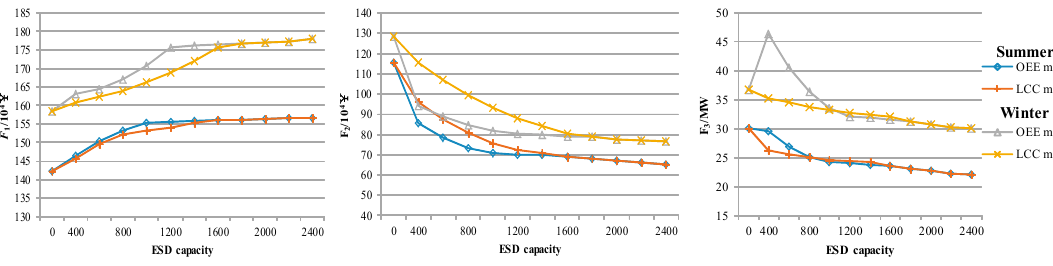
Figure 15. The objective function values of MECS operation under different ESD capacities.